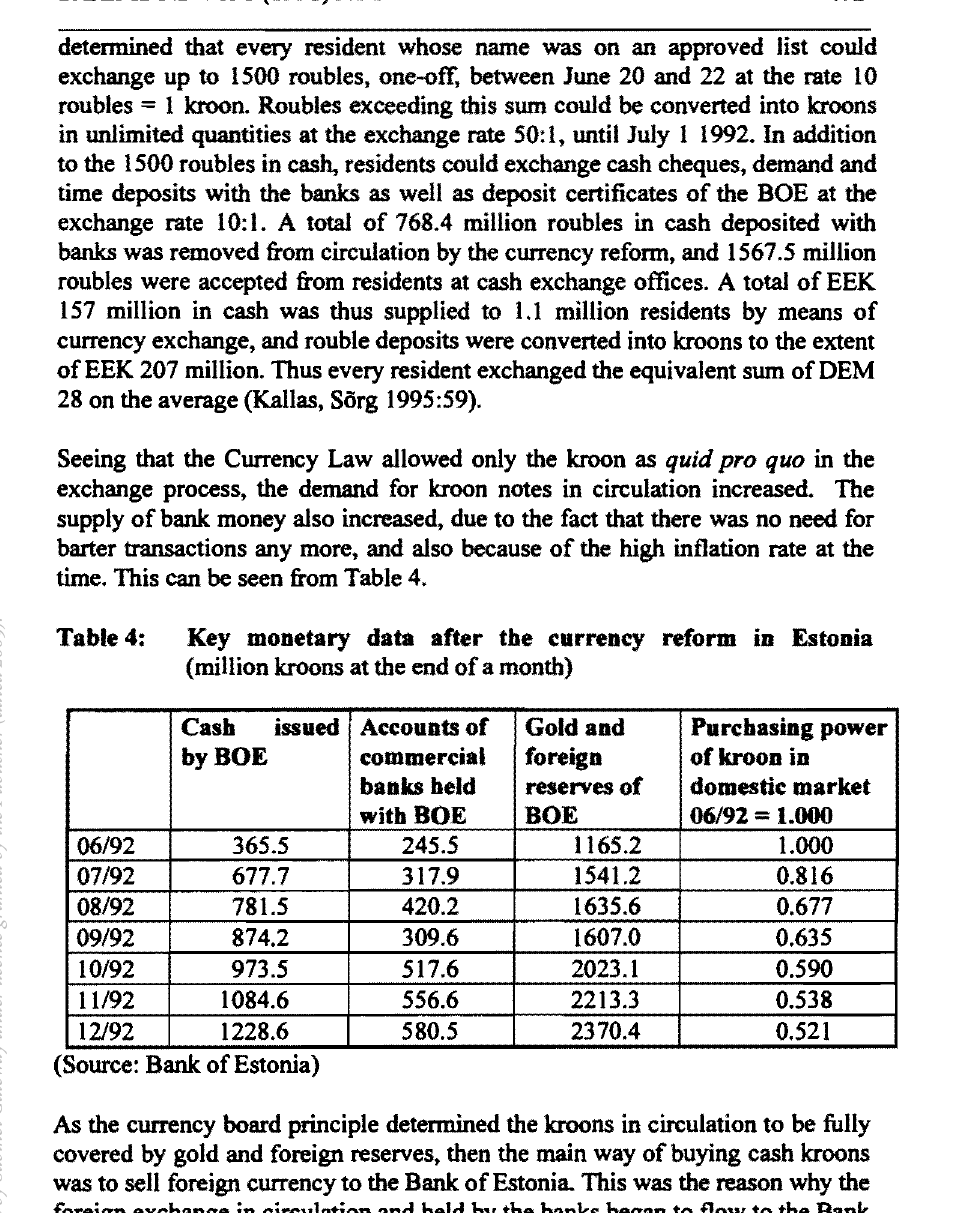
Key monetary data after the currency reform in